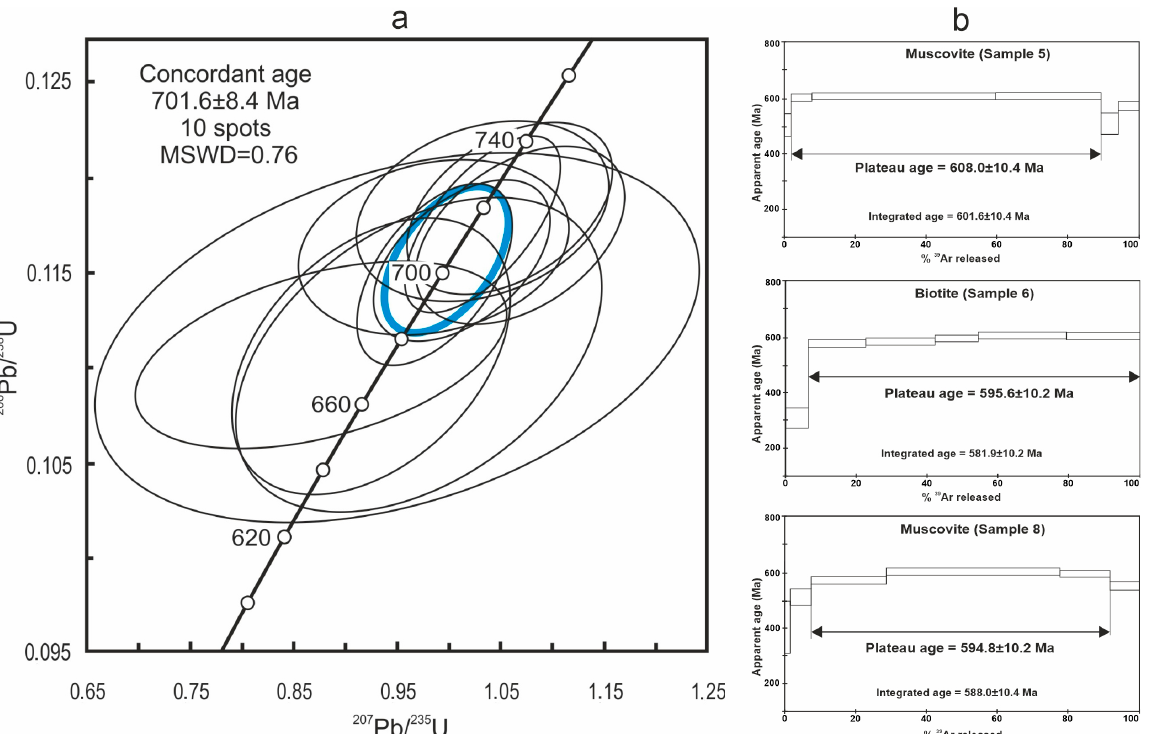
Figure 22. ( a ) Zircon U–Pb concordia diagram for the mafic rock (sample 14) ; ( b ) 40 Ar– 39 Ar ages for muscovite and biotite from metapelitic blastomylonites. Blue ellipse—average age values. Either the plateau (arrows) or integrated age is given for each sample. Sample locations are shown in Figure 3.